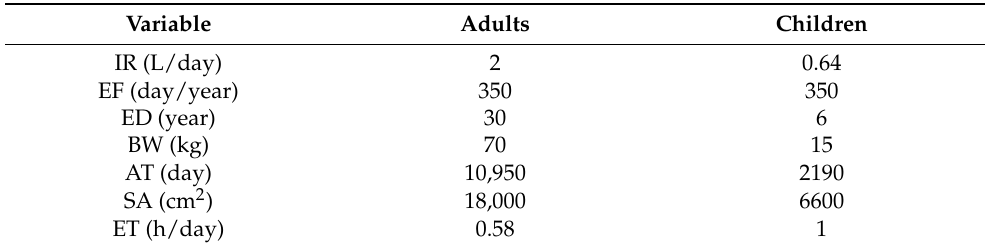
Table 3. Default values in the calculation of average daily exposure dose (ADD) through ingestion and dermal